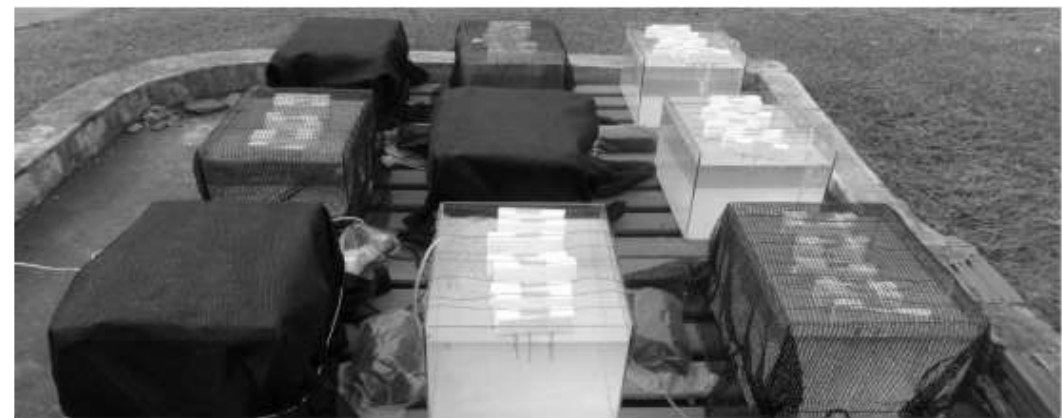
Figure 3. Random distribution of